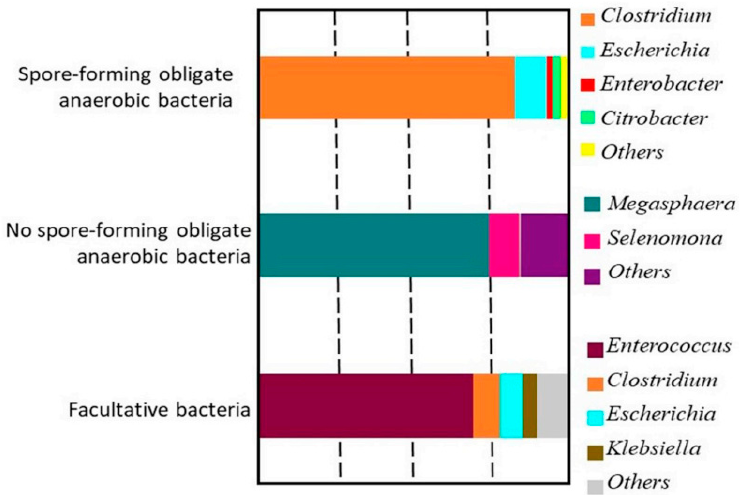
Figure 6. Three examples of the taxonomic composition of H 2 -producing communities dominated by the different groups of H 2 -producing microorganisms [108].